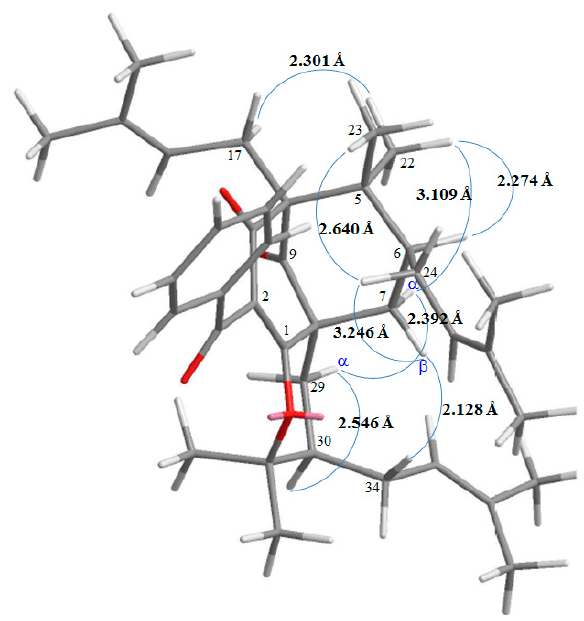
Figure 7. Selected NOESY correlations and relative configuration of 2 .